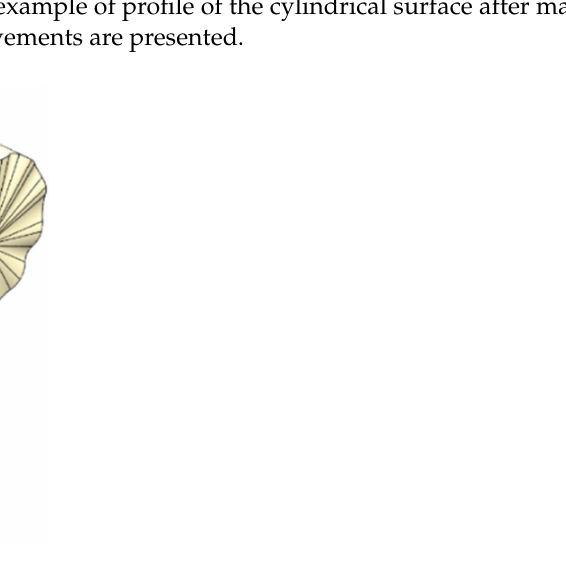
Figure 9. Example of the end face surface profile after machining on the spindle with error movements.